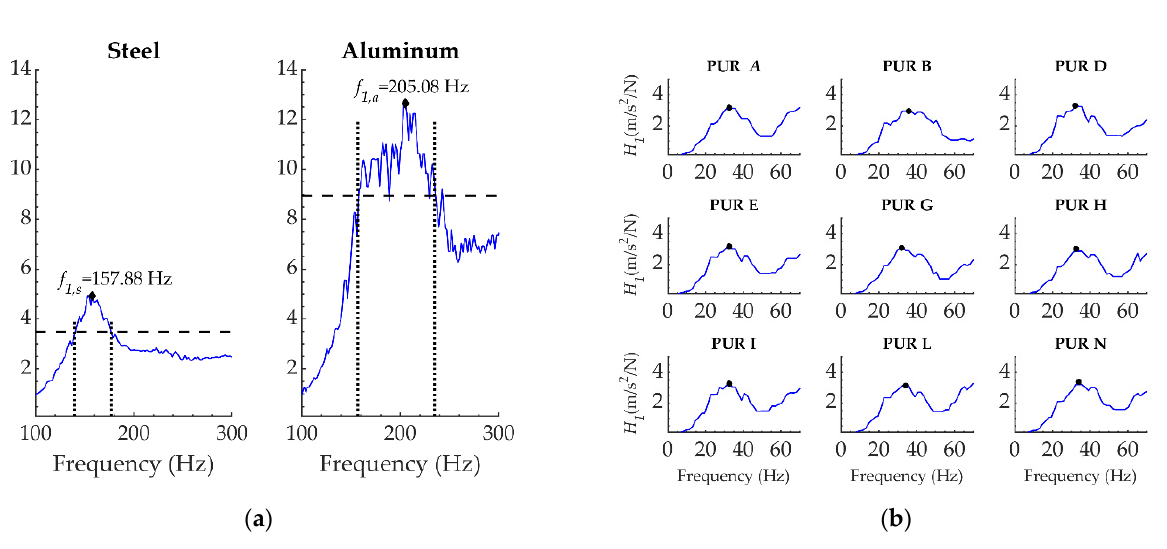
Figure 8. Frequency response functions, H 1 , for ( a ) steel and aluminium specimens and ( b ) polyurethane specimens at different densities. In both figures, the marker shows the fundamental frequencies; in Figure ( a ), the application of the half-power bandwidth method for the damping evaluation is also illustrated.